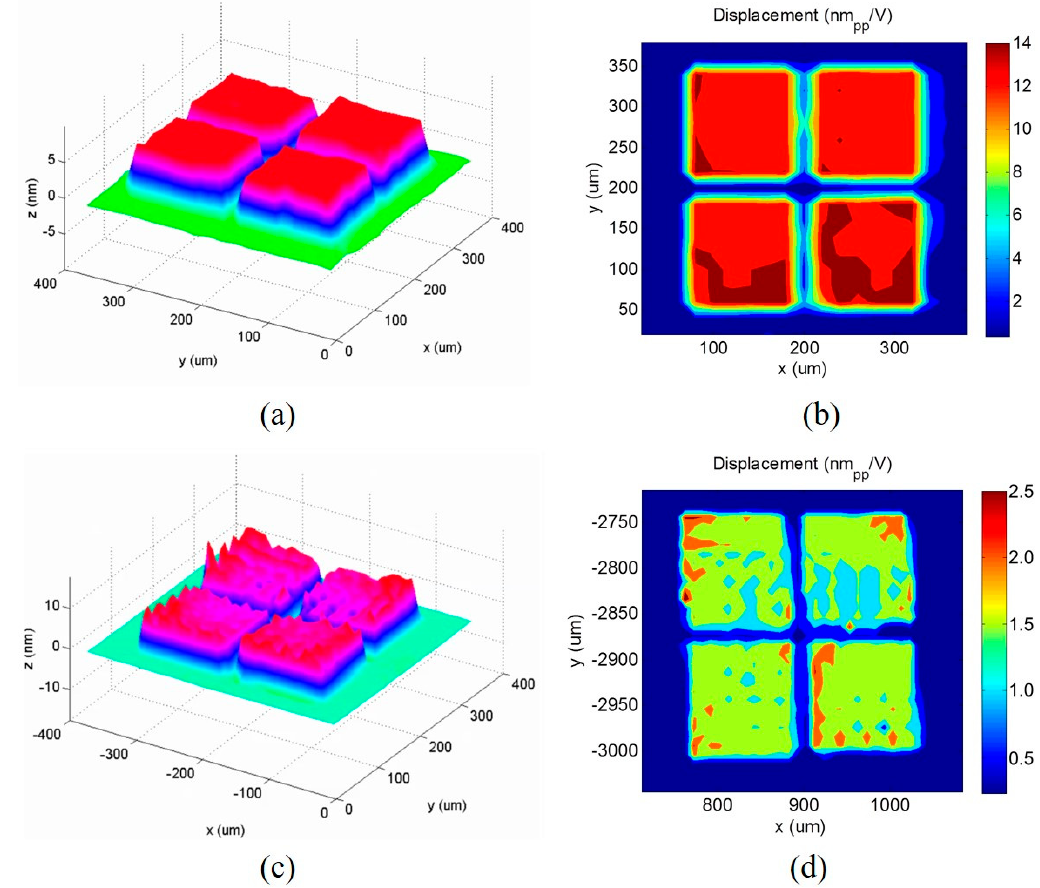
Figure 7. The dynamic plate displacement measurements from a laser Doppler vibrometer. ( a ) A 3D perspective view at the moment of the positive maximum peak displacement of the plane 2D CMUT element in air and ( b ) its contour plot of the maximum peak-to-peak displacement over the measurement time. ( c ) A 3D perspective view at the moment of the positive maximum peak displacement of the truss 2D CMUT element in oil and ( d ) its contour plot of the maximum peak-to-peak displacement over the measurement time.